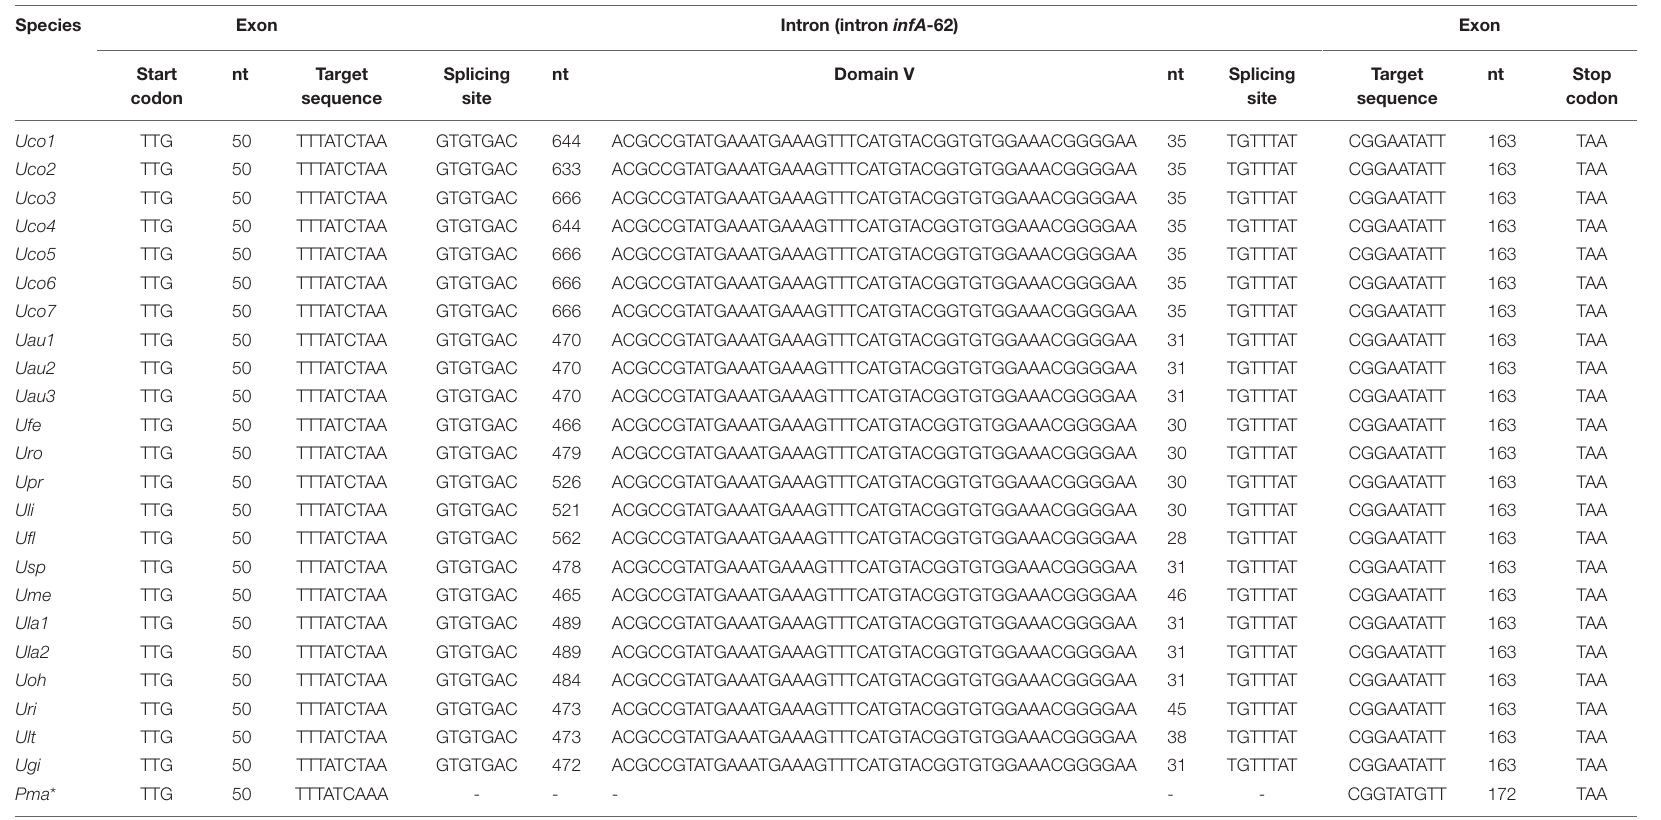
TABLE 4 | One group II (derived) intron was identified in the infA genes of all sequenced Ulva chloroplast genomes.